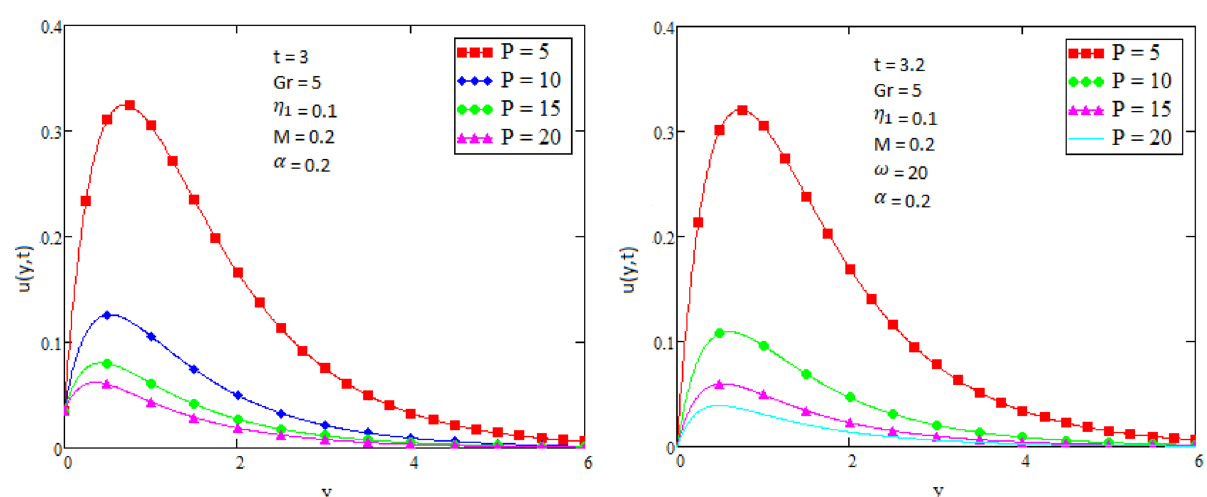
Figure 9. Velocity profile for different values of Prandtl number